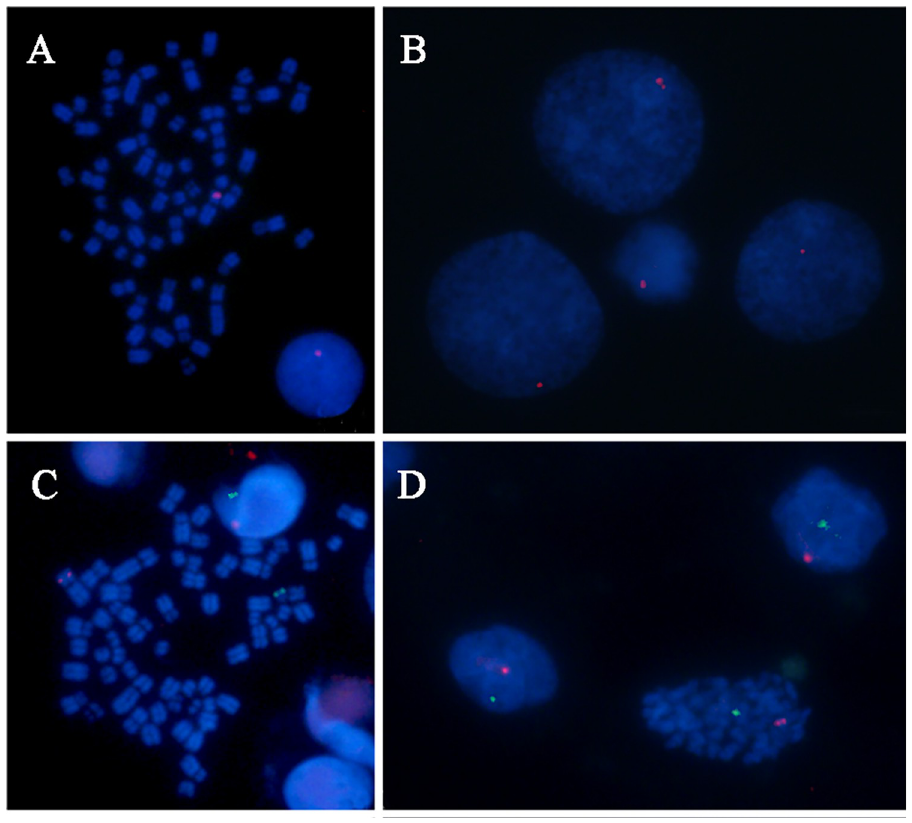
Fig 4. Specific identification of the X and Y chromosomes by FISH. (A) and (B) Blood cells from the female foal. (C) Metaphase spread derived from the blood sample of the male foal. (D) Interphase cells from the MSC culture used as nuclear donor. Red color indicates the X chromosome probe and green color indicates the Y chromosome probe. Magnification 1000X.